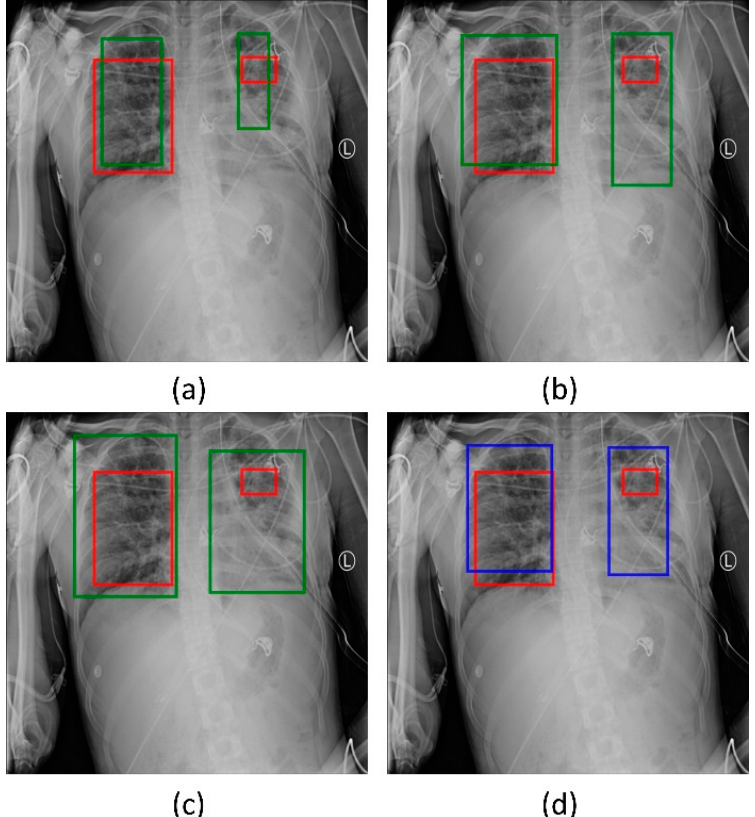
Figure 8. Bounding box predictions using the ensemble of RetinaNet models initialized with varying weights for the classifier backbones. Green boxes denote the individual model predictions, blue boxes denote the ensemble predictions and red boxes denote the ground truth. ( a ) ResNet-50 with CXR image modality-specific weights + focal Tversky loss; ( b ) ResNet-50 with CXR image modality- specific weights + focal loss; ( c ) ResNet-50 with random weights + focal loss, and ( d ) the ensembled bounding box prediction.